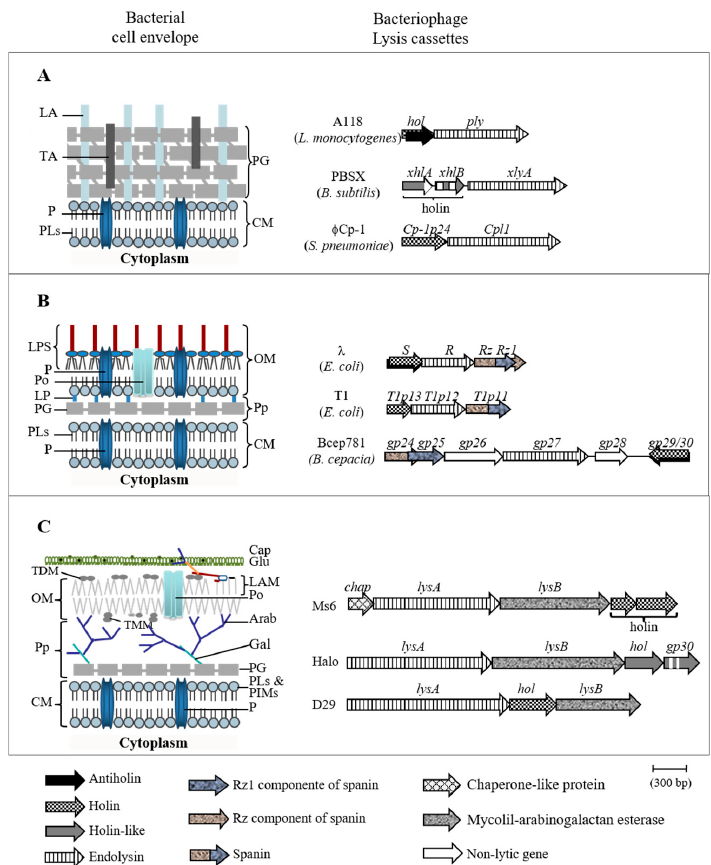
Figure 1. Cell envelopes of bacteria (left) and representative lysis cassettes of their infecting phages (right). ( A ) Gram-positive bacteria; ( B ) Gram-negative bacteria; ( C ) Mycobacteria. The white segments in holin-like genes indicate the number and position of transmembrane domain coding sequences. Abbreviations: CapGlu, capsular glucan CM, cytoplasmic membrane; LA, lypoteichoic acid; LAM, lipoarabinomannan; LP, lipoprotein; LPS, lipopolysaccharide; P, protein; PG, peptidoglycan; PIMs, phosphatidylinositol mannosides; PLs, phospholipids; PO, porin; Pp, periplasm; TDM, trehalose dimycolate; TMM, trehalose monomycolate. Adapted from reference [5] with